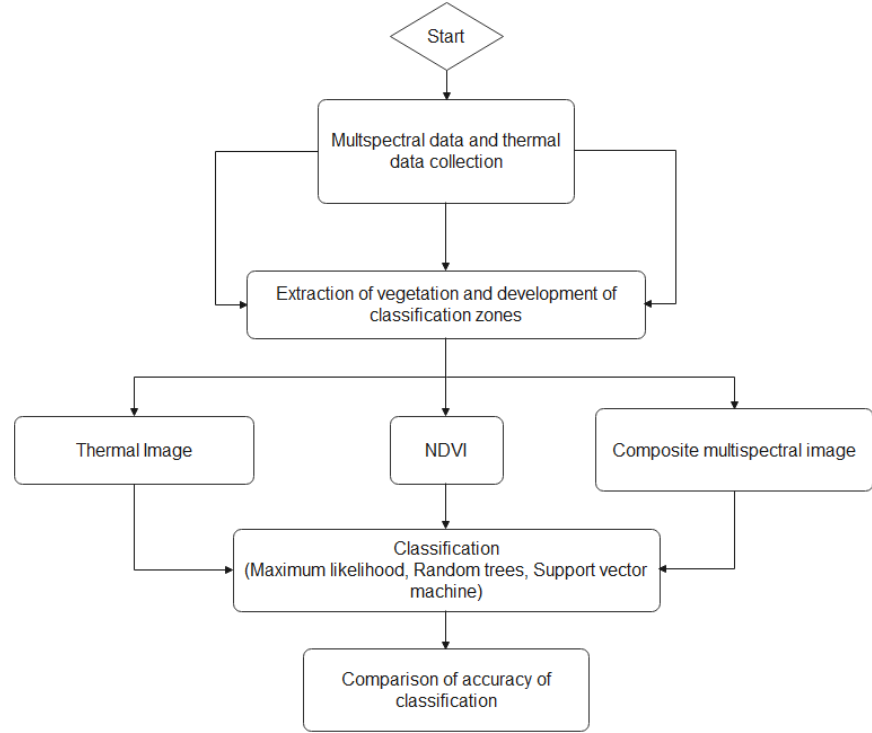
Figure 3. Image processing and predicition analysis steps for weed classification.